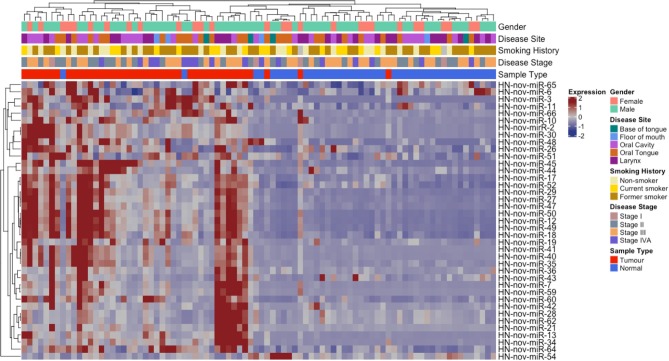
Unsupervised hierarchal clustering analysis comprising 39 HNnov-miR expressed in both tumors and non-malignant tissue. The dendogram shows two clusters, the first enriched by non-neoplastic samples (novel miRNA expression predominantly low) and the second by tumor samples (novel miRNA expression predominantly high). Heatmap annotation bars show some of the clinical parameters associated with each tissue sample, including gender, disease site and stage, smoking history, and tissue type.